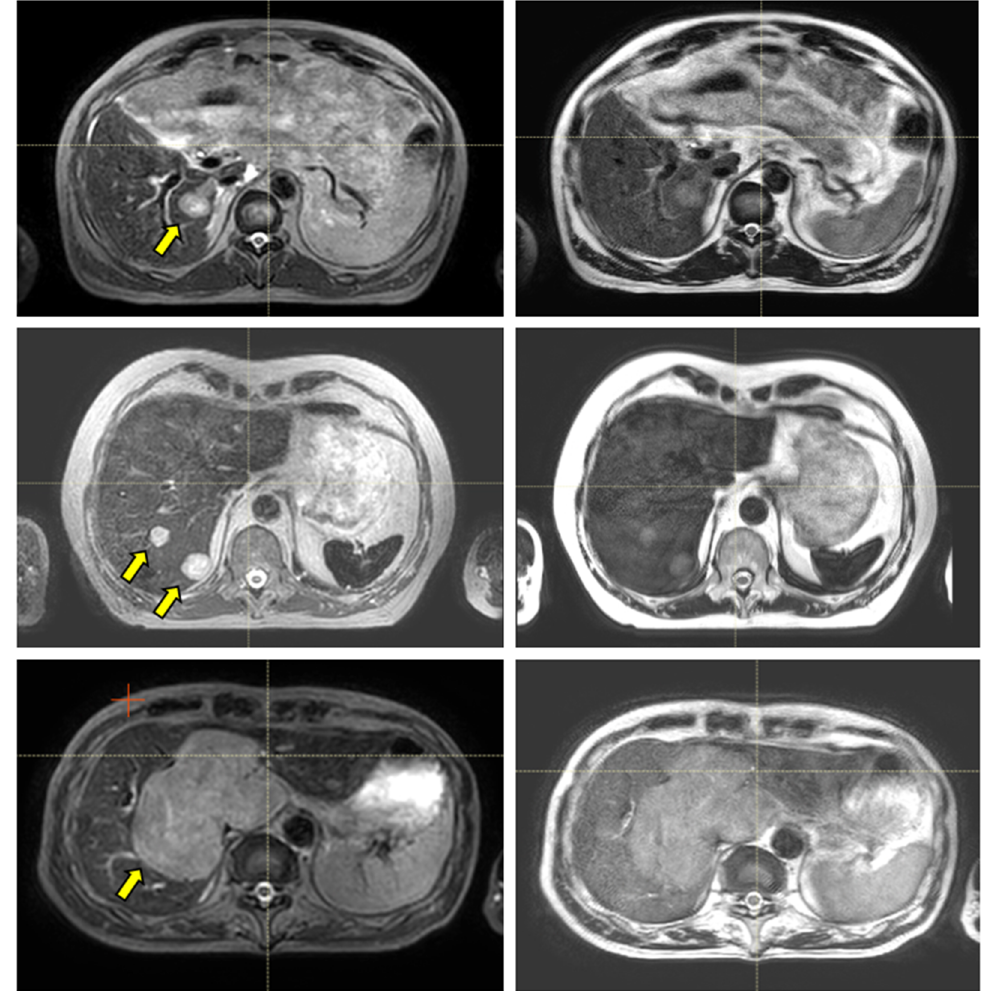
Figure 3. Liver examples depicting the comparison between the T2w-Nav ( first column ) and T2w-Ave ( second column ) image sequences. The target(s) location is identified by the yellow arrow. The samples correspond to Patients 7, 8, and 9 as per Table 1. These cases were planned with the T2w-Nav image data.